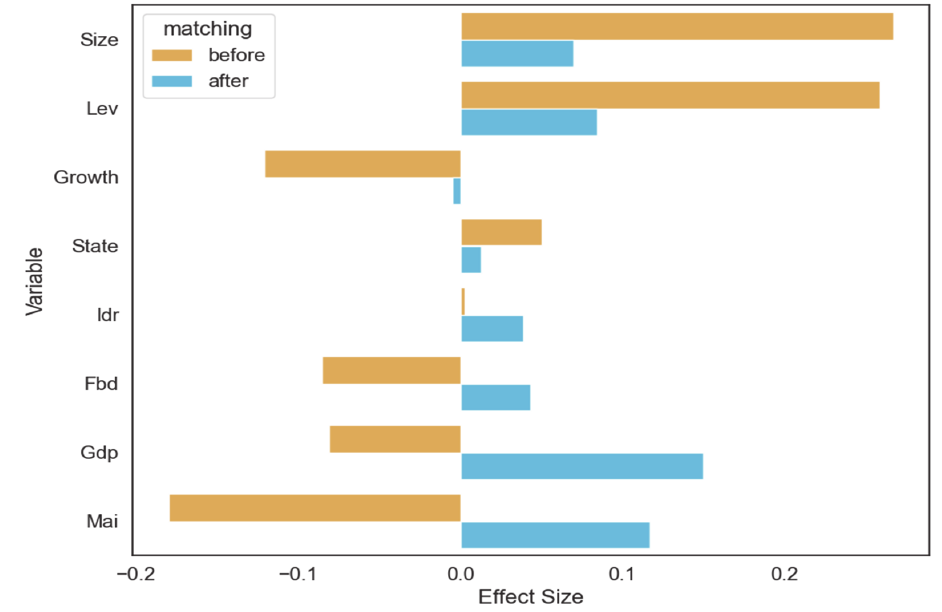
Figure 4. Standardized mean differences of covariates before and after matching.